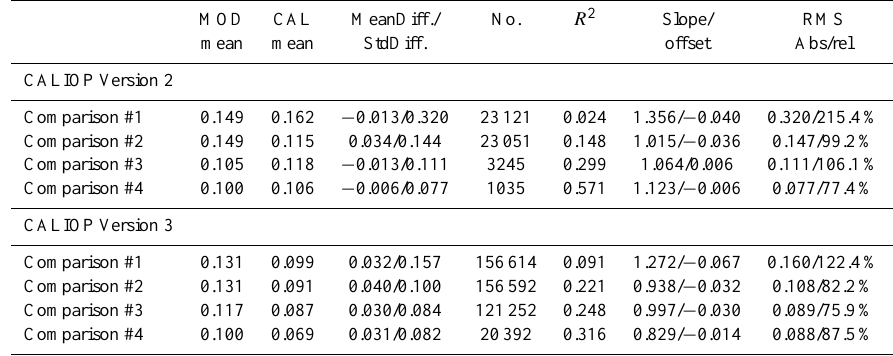
Table 4. MODIS vs. CALIOP AOD532, July 2007, over-ocean. MOD CAL MeanDiff./